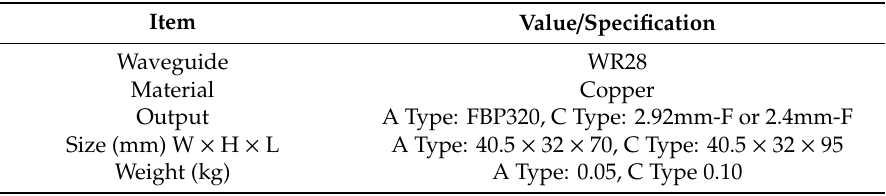
Table 1. Technical specifications of hardware.